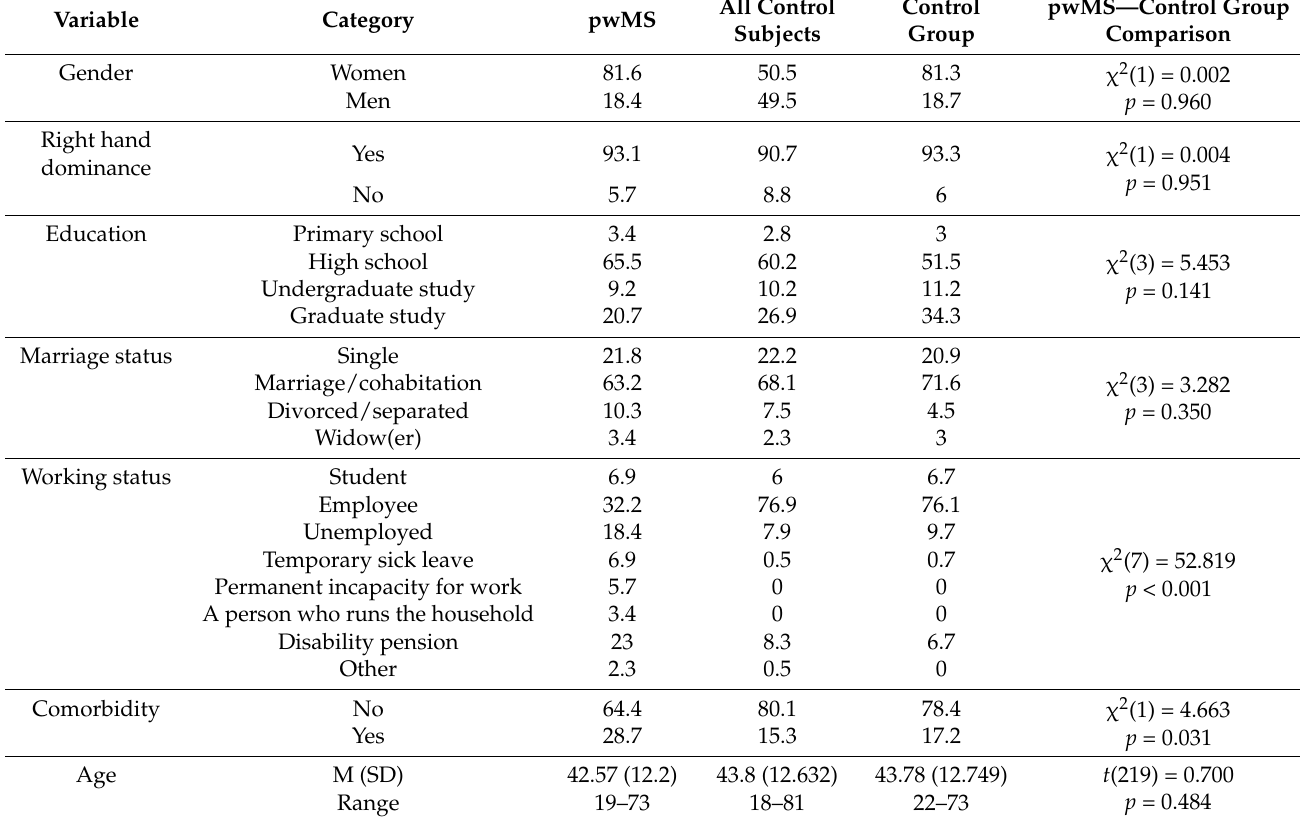
Table 1. Comparison of percent of participants with certain demographic characteristics in pwMS ( n = 87), all control subjects ( n = 216) and a subsampled control group ( n =